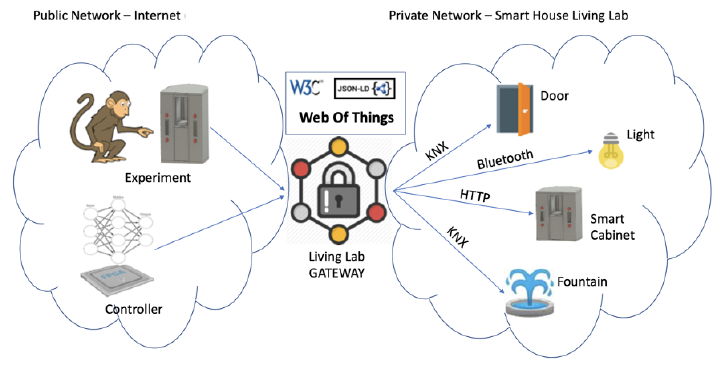
Figure 1. Living Lab Gateway solution for Plan4Act’s demo